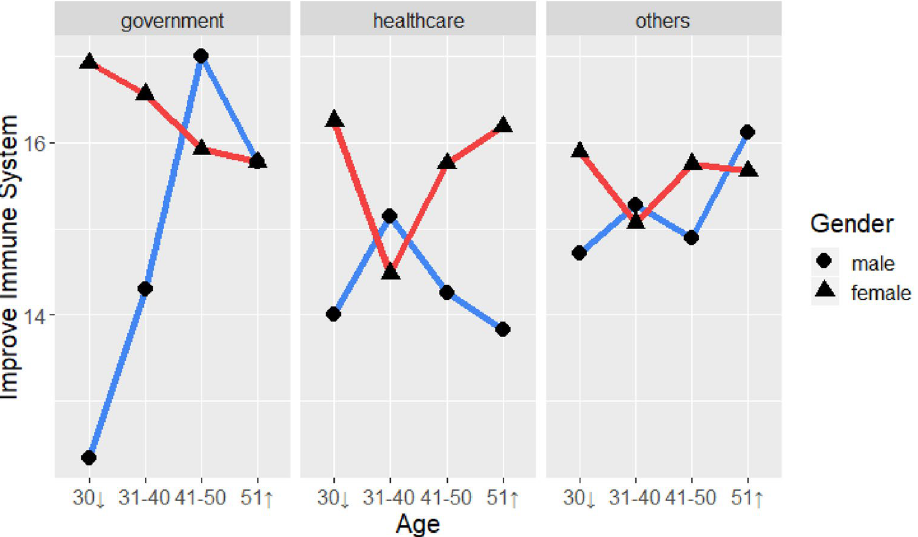
Figure 10. Three-way interaction of strengthening one’s immune system with gender and age for government